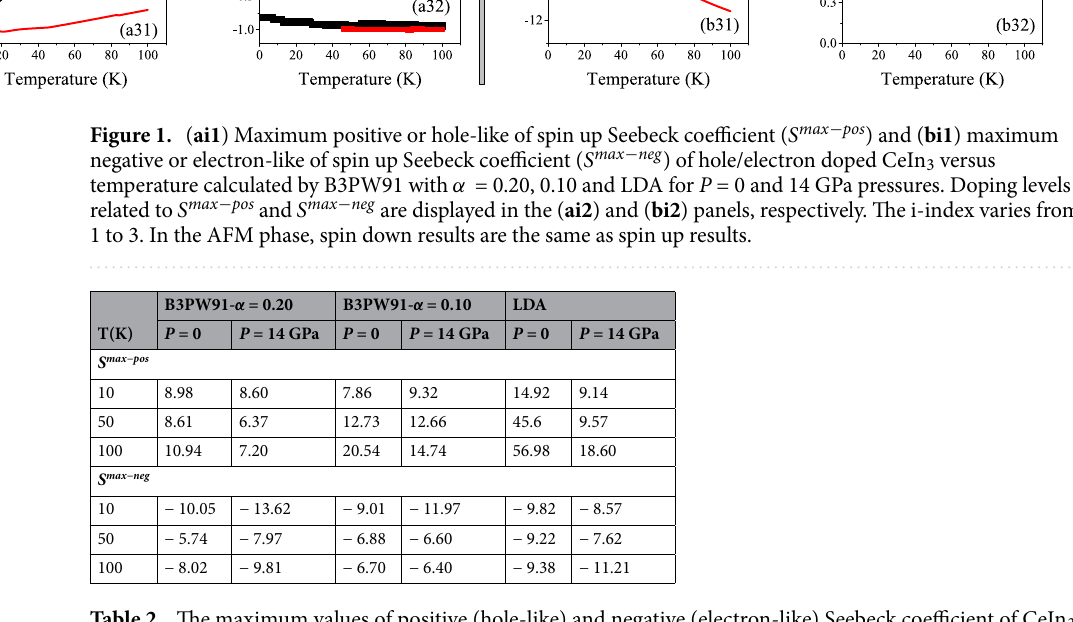
Table 2. The maximum values of positive (hole-like) and negative (electron-like) Seebeck coefficient of CeIn 3 at P = 0 and 14 GPa using B3PW91 with α = 0.20, 0.10 and LDA at specified temperatures T = 10, 50, and 100 K. The unit of numbers is µ V K